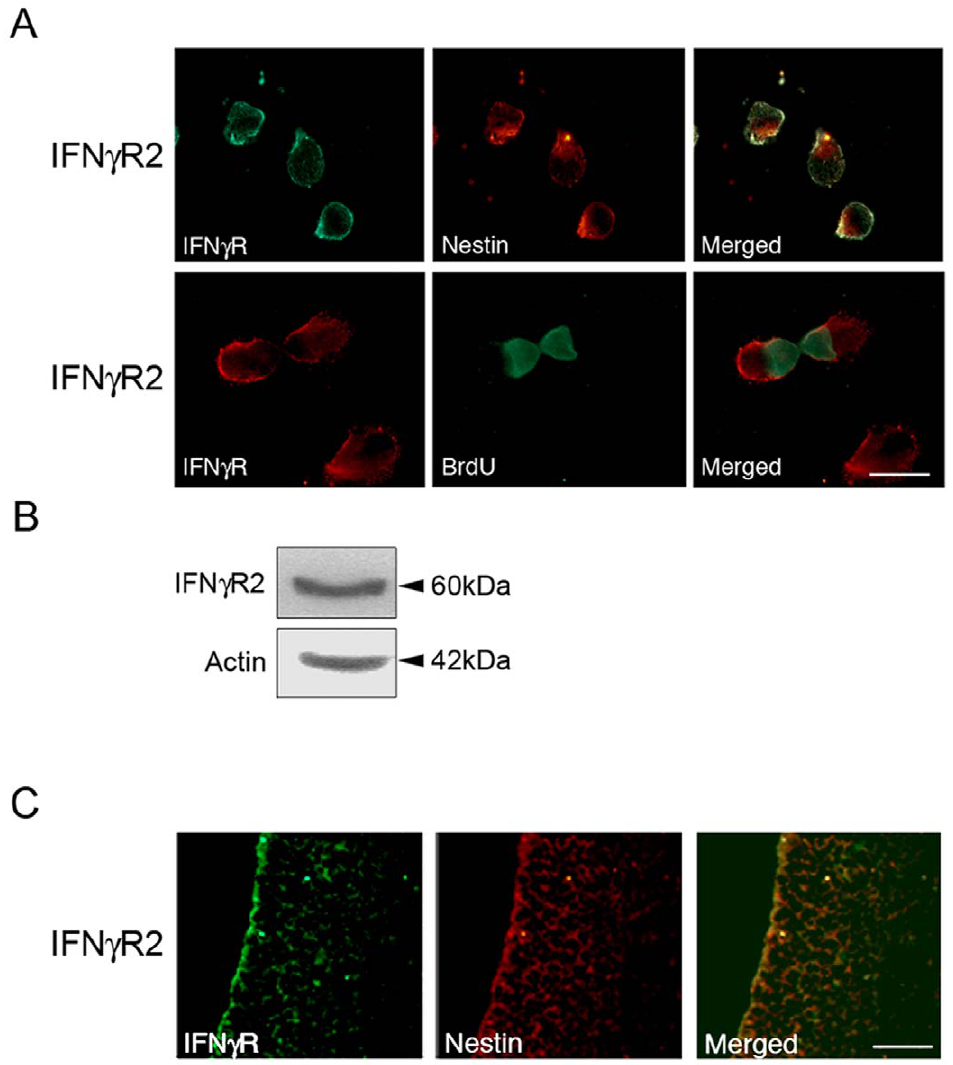
Figure 1. Neural progenitor cells express IFN c receptors. NPCs were prepared from embryonic, E17 old rat brain and cultured as described in Methods. ( A ) Upper panel. Immunostaining using antibodies against the IFN c R2 receptor (green fluorescence) and against nestin (red fluorescence) as a marker for NPCs. Control without primary antibody showed no staining. Lower panel. BrdU labeling was done as described in Methods. Note expression of IFN c R2 in dividing NPCs. Scale bar, 10 m m. ( B ) Immunoblot shows the presence of IFN c R2. b -actin was used as control. ( C ) Sections from E17 rats were double-stained using antibodies against nestin and IFN c R2. Note coexpression in cells in neuroepithelium. Scale bar, 90 m m.